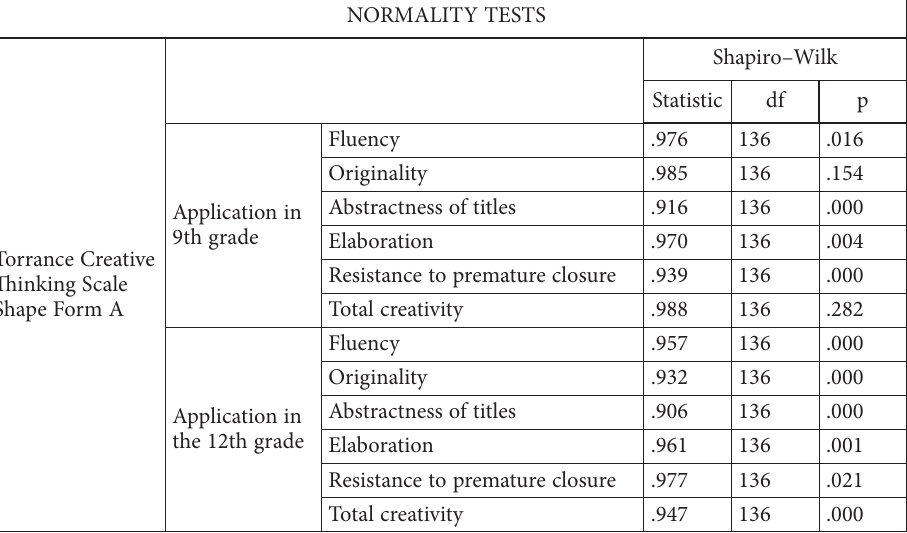
Table 3. Normality analysis of Torrance Test of creative thinking (Figural Form A) and subscale scores (source: created by